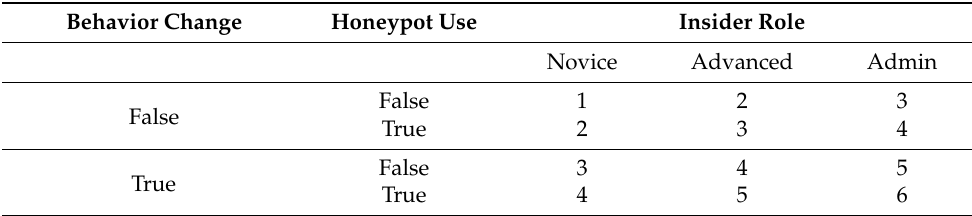
Table 3. Opportunity Score.